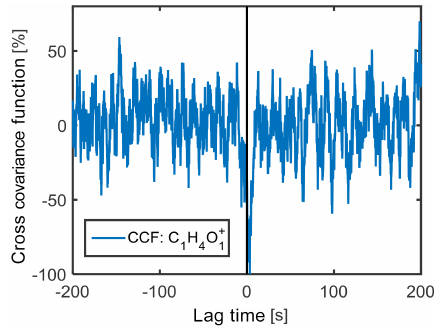
Figure A1. Thirty-minute cross covariance function of C 5 H + 15 June 2012, 14:15. The function was normalized to the maximum. A clear maximum can be seen, slightly shifted to the right by the lag time.